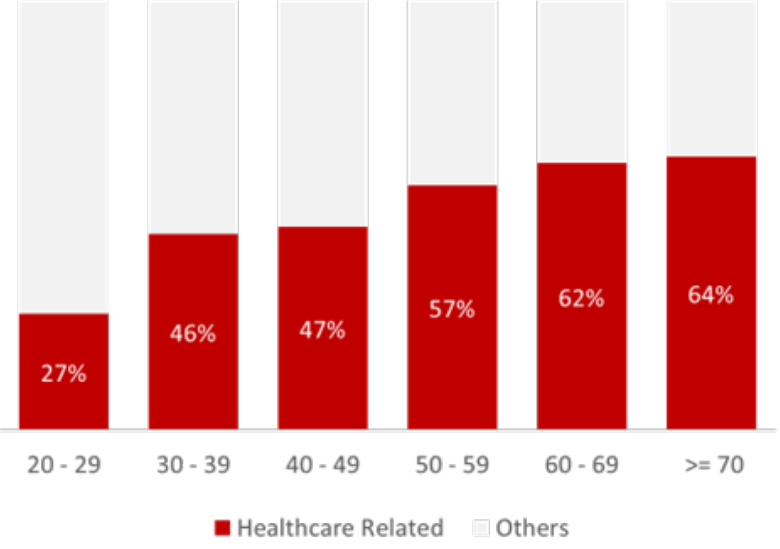
Figure 6. Spending by age bands.